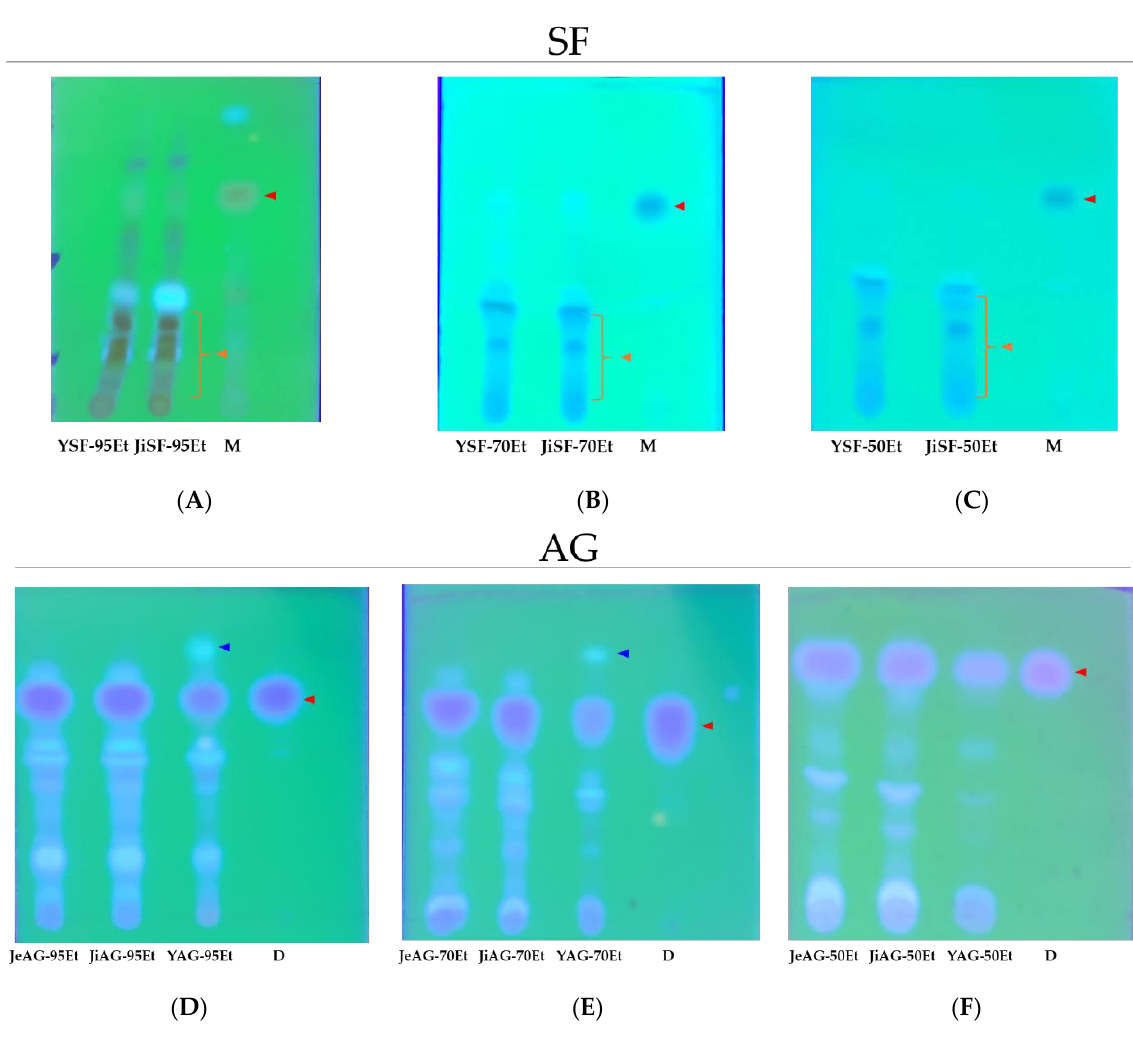
Figure 1. TLC analysis of SF ( A – C ) and AG ( D – F ) extracts. The standard compounds used for SF and AG extracts were maackiain and decursin, respectively. Amounts of extracts and standards loaded were 50 µg and 10 µg, respectively. Solvent compositions were established using methanol (MeOH), ethyl acetate (EtOAc), and toluene (Tol): ( A ) MeOH:EtOAc:Tol = 1:2:7; ( B )